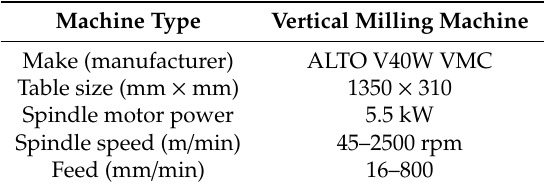
Figure 1. Experimental set-up used for the friction welding of tube to tube plate using an external tool (FWTPET) + friction stir processing (FSP) technique: ( a ) vertical milling machine (VMM); ( b , c ) magnified view indicating components of VMM. Table 1. Specification of the vertical milling machine used for the FWTPET + FSP